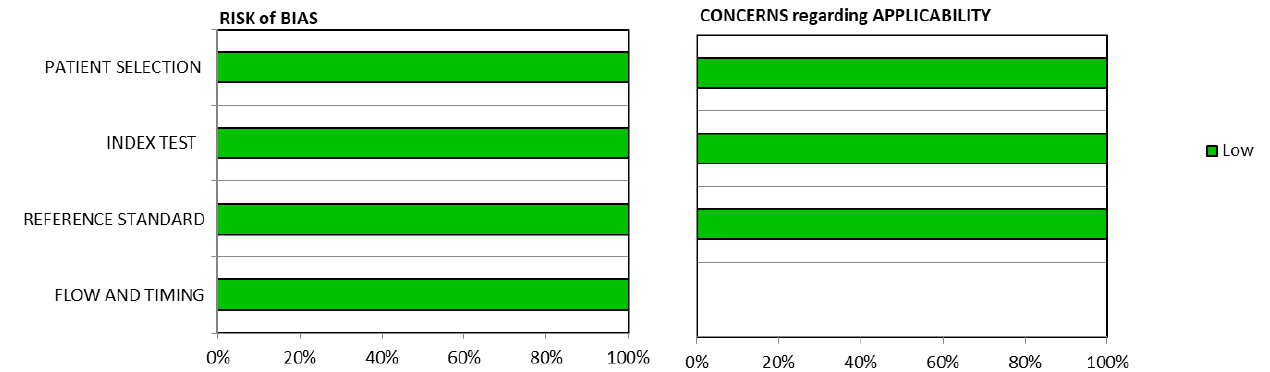
Figure 3. Graphic representation of the bias risk results assessed through QUADAS-2. All the selected articles have a low risk of bias and low concerns regarding applicability in all the domains as depicted by green bands.